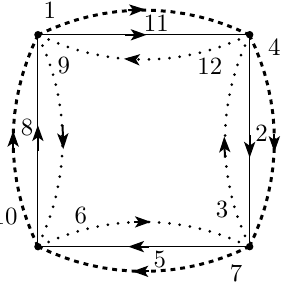
Fig. 2: A rainbow eulerian circuit of M h with color sequence (dash, line,